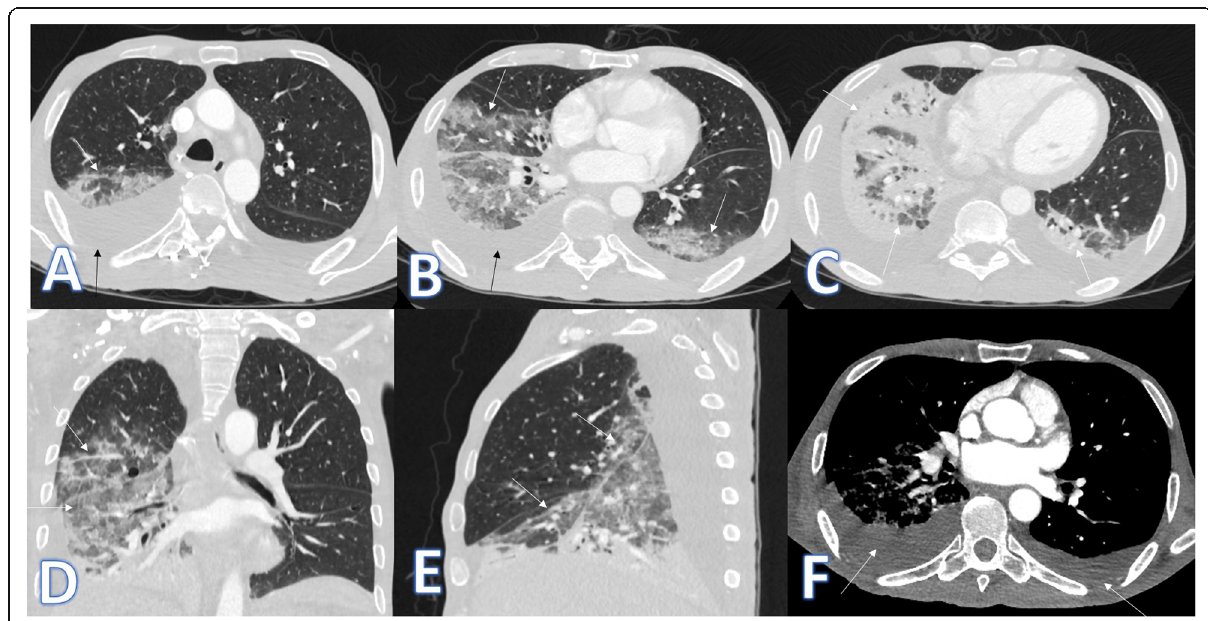
Fig. 2 A 53-year-old male patient with cough and dyspnoea. CT showed multiple consolidative patches with ground glass appearance involving